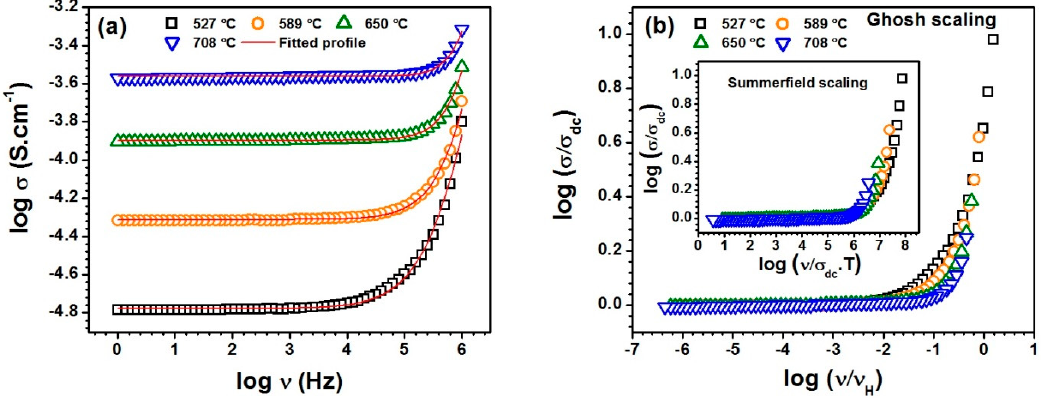
Figure 6. ( a ) The typical electrical conductivity spectra of SST5 composition fitted with Jonscher’s power law and ( b ) scaling of conductivity spectra at measured temperatures for the composition